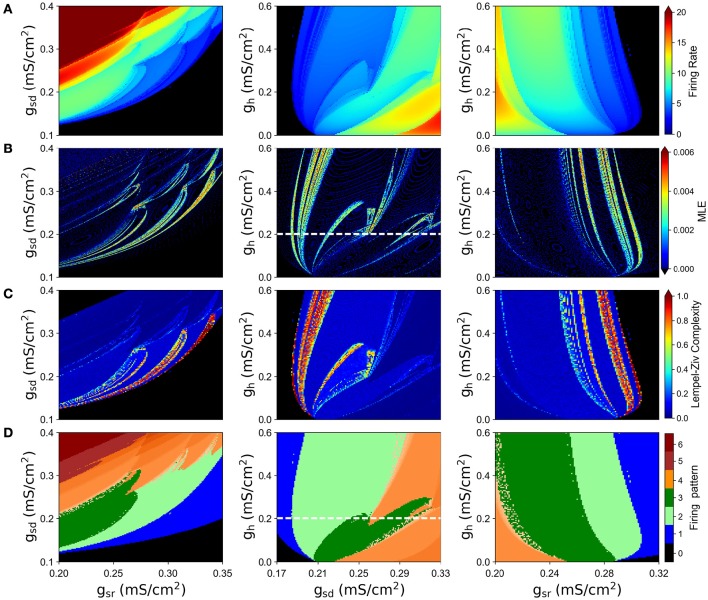
Chaotic behavior of the model at different combination of the slow conductance densities gsd, gsr and gh. (A) Firing rate in spikes/s. (B) MLE of the voltage trajectories. (C) Lempel-Ziv complexity. (D) Firing pattern. The color bar indicates: 0, no oscillations; 1, sub-threshold oscillations (no spikes); 2, oscillations and spikes with skipping; 3, regular tonic spiking; 4, burst firing (the shade represents the number of spikes per bursts); 5, tonic with firing rate between 20 and 50 spikes/s; 6, firing rate higher than 50 spikes/s.